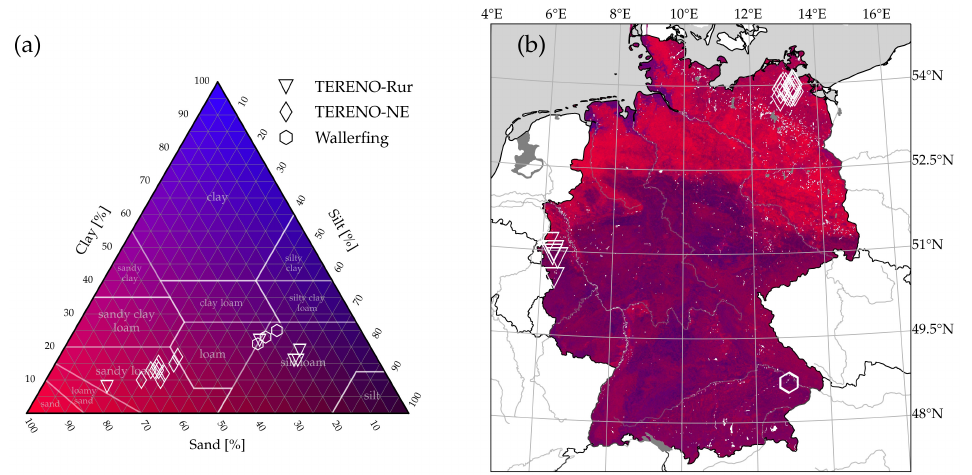
Figure 1. Soil composition for the test sites ( a ) and similarly color coded soil map for Germany ( b ), derived from Soilgrid’s data top layer sand and clay content